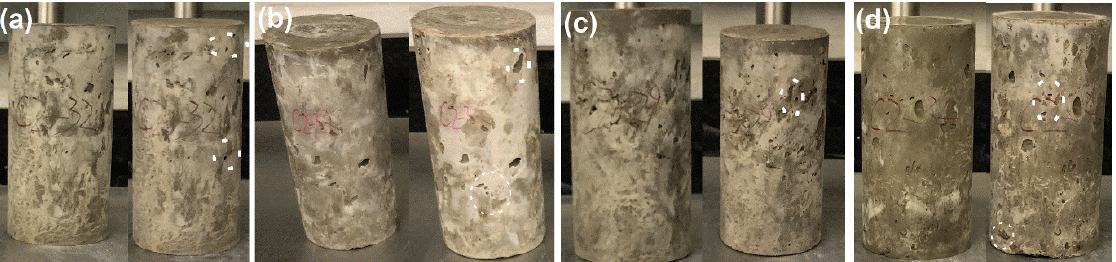
Figure 11. Photos of soilcrete samples before and after F/T cycles: ( a ) C2-D56T5N1, ( b ) C2-D56T2N1, ( c ) C2-D56T10N1, and ( d ) C2-D56T5N4. ( c ) C2-D56T10N1, and ( d )